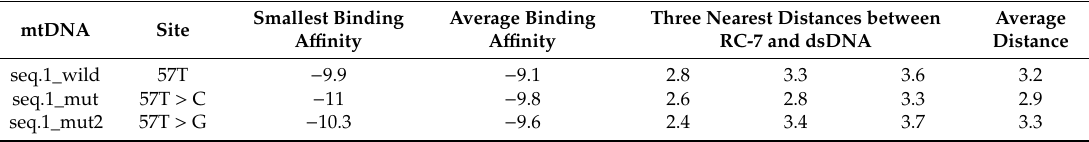
Table 2. Binding a ffi nities (kcal / mol) and three nearest distances (Å) of RC-7 and mtDNA (57T; 57T > C; 57T >